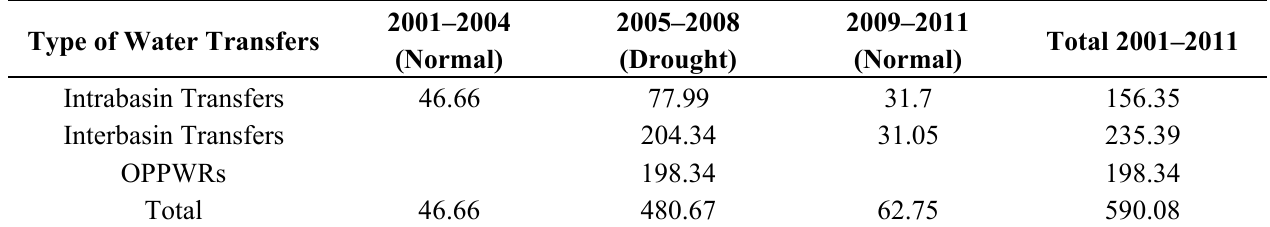
Table 1. Total trade volume through water markets under drought and normal